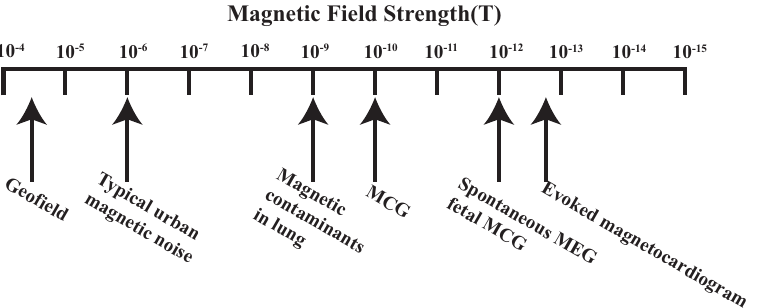
Figure 13. Amplitude of various biomagnetism signals in comparison to the geofield and urban magnetic noise [123].